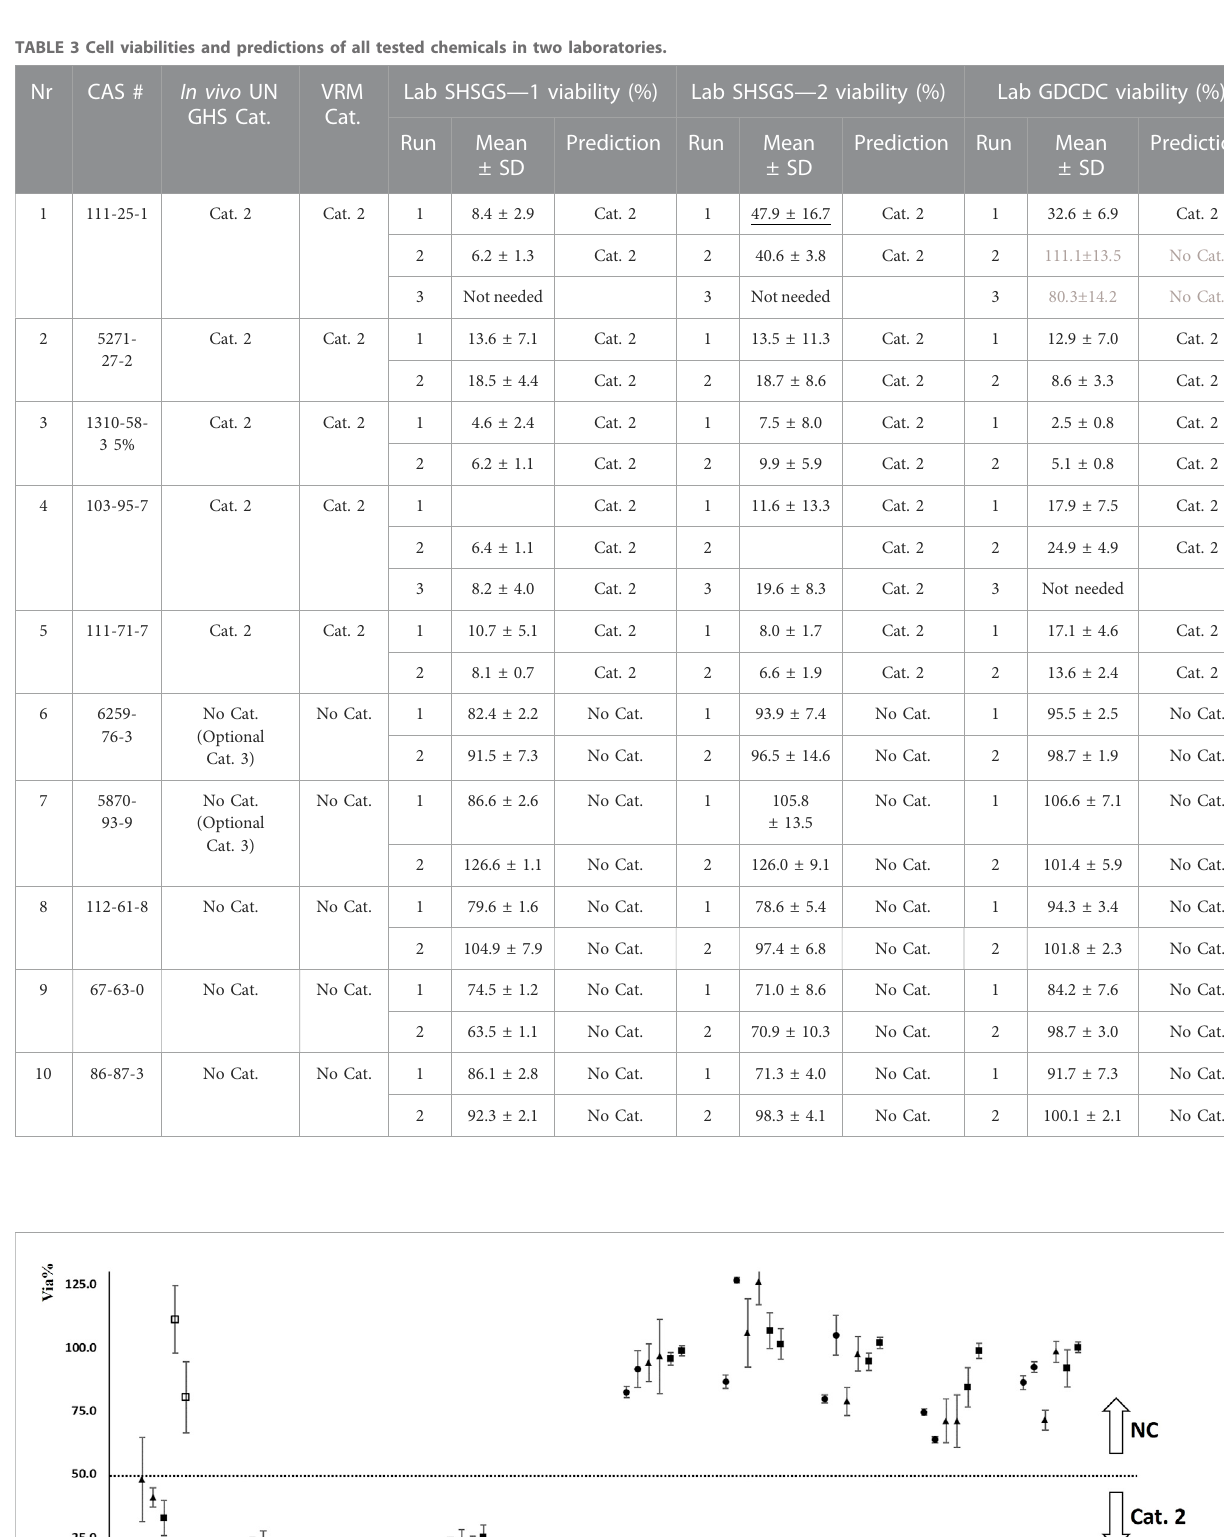
TABLE 3 Cell viabilities and predictions of all tested chemicals in two laboratories. Nr CAS # In vivo UN VRM Lab SHSGS — 1 viability (%) Lab SHSGS — 2 viability (%) GHS Cat. Cat. Run Mean Prediction Run Mean ± SD